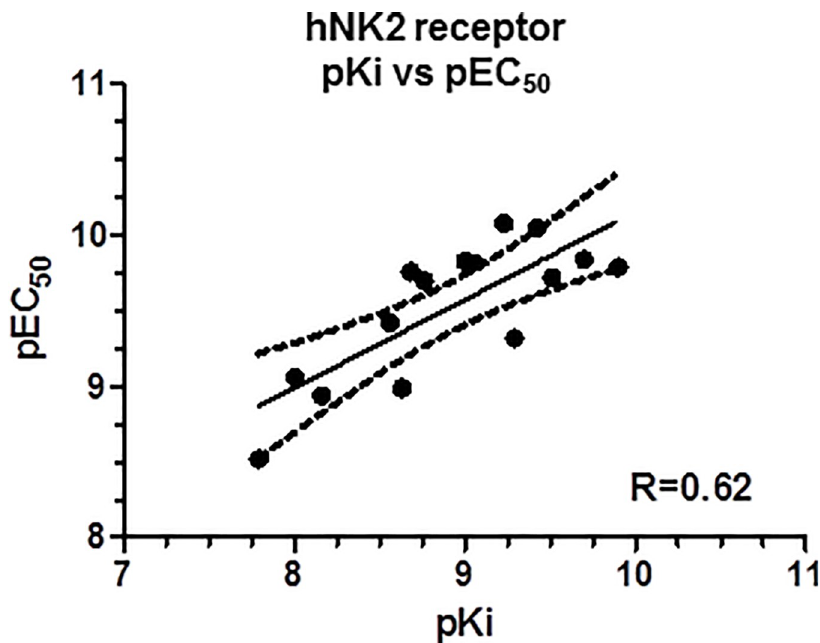
Fig 6. Correlation between displacement of [ 125 I]-NKA binding (pKi) and intracellular calcium response (pEC 50 ) at human recombinant NK2 receptors expressed in CHO cells. Scatterplot and regression analysis of pKi versus pEC 50 values at human recombinant NK2 receptors for a series of NK2 agonists. Solid line: regression analysis; dotted lines: 95% confidence intervals. For [Arg 5 , β -Ala 8 ]-NKA(4–10) and [ β -Ala 8 ]-NKA(4–10), pIC 50 values were used.